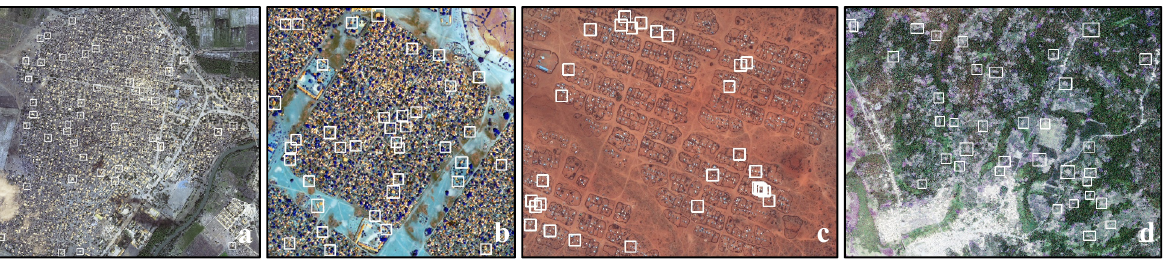
Figure 9. The four datasets used in this study, entitled ( a ) Jowhaar, ( b ) Hagadera, ( c ) Bokolmanyo, ( d ) Akonolinga. Dataset details are given in Table 1.